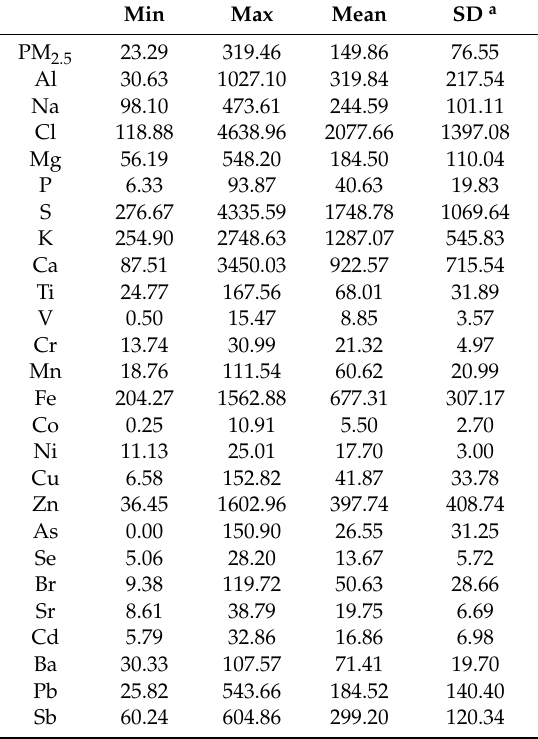
a SD: Standard deviation.